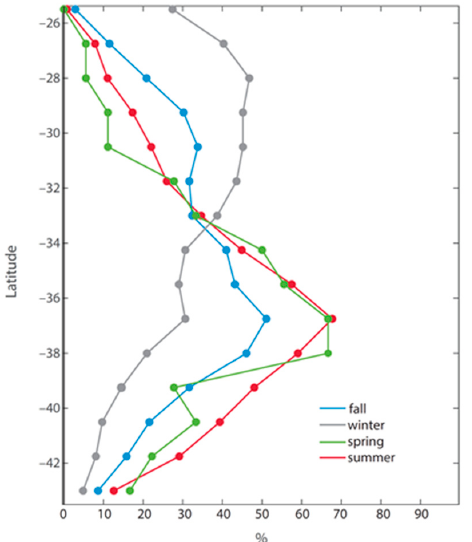
Figure 9. Annual density of anticyclones in the southern hemisphere (anticyclone per area per year). ( a ) All anticyclones, ( b ) migratory anticyclones and ( c ) stationary anticyclones.